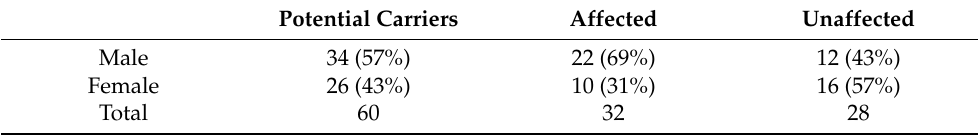
Table 2. Gender disbalance in patients harboring p.G90D in RHO in our study.